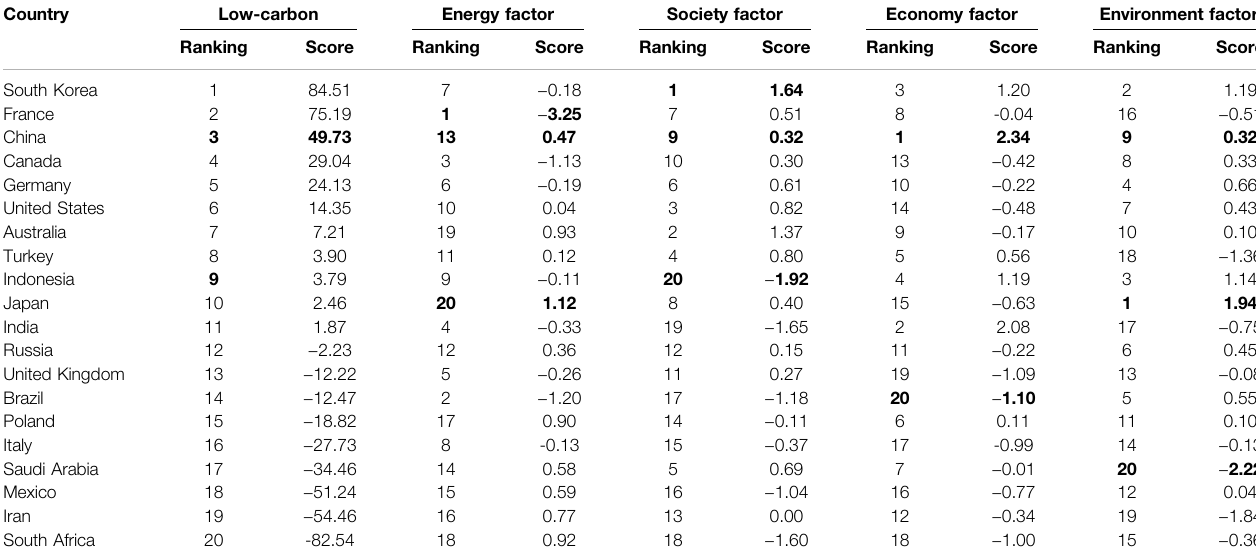
TABLE 5 | Rankings and scores of low-carbon economy development level.